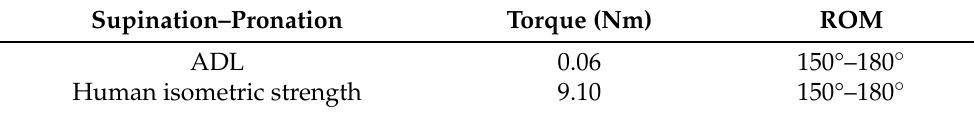
Table 2. ROM and torque capabilities